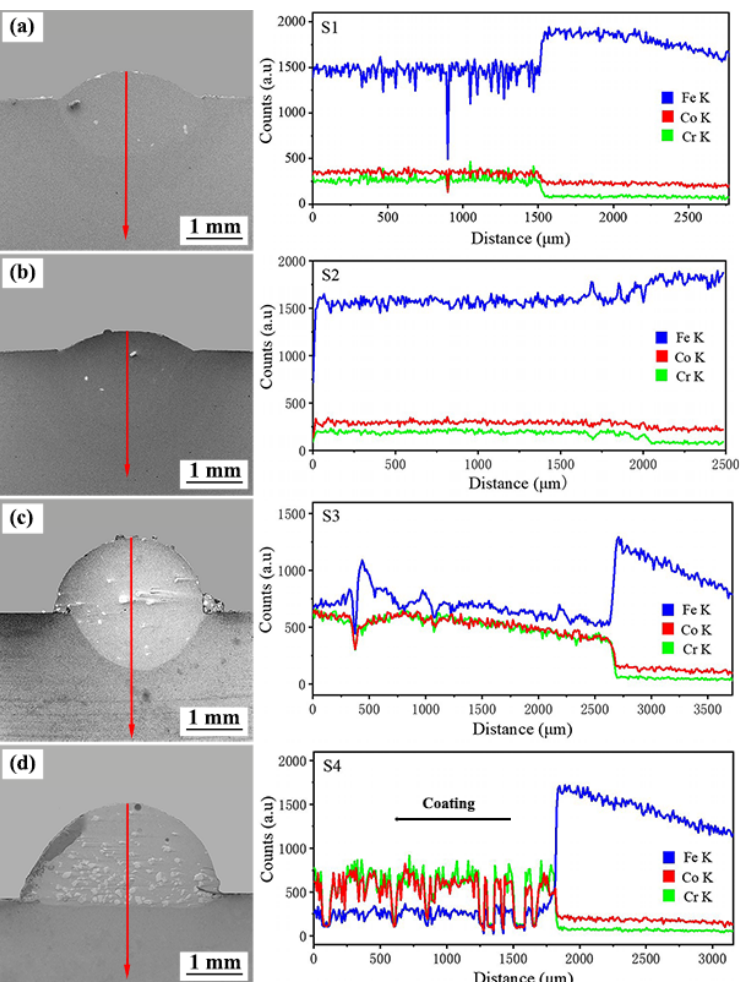
Figure 9. Line EDX between the Stellite 6/WC composite coating and the substrate of different specimens: (a) S1; (b) S2; (C) S3; (d) S4.